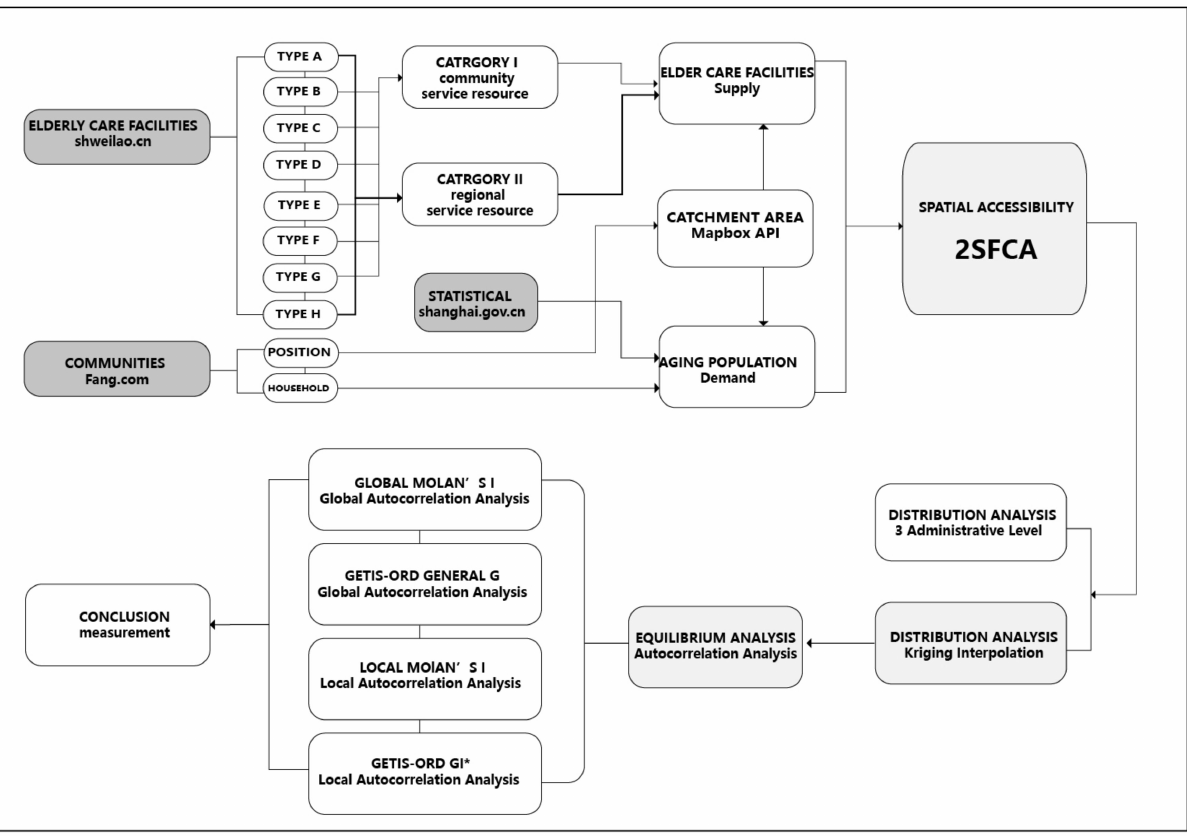
Figure 1. Research